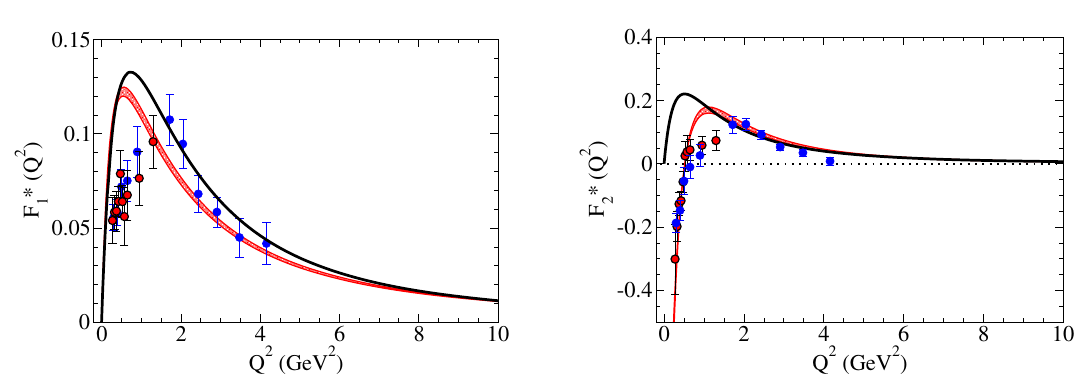
Figure 2. γ ∗ N → N (1440) transition form factors. The solid line represent the estimate of the covariant quark model [43]. The red band represent the estimated from AdS / QCD taking into account the uncertainty of the couplings [48]. Data from CLAS [45–47].